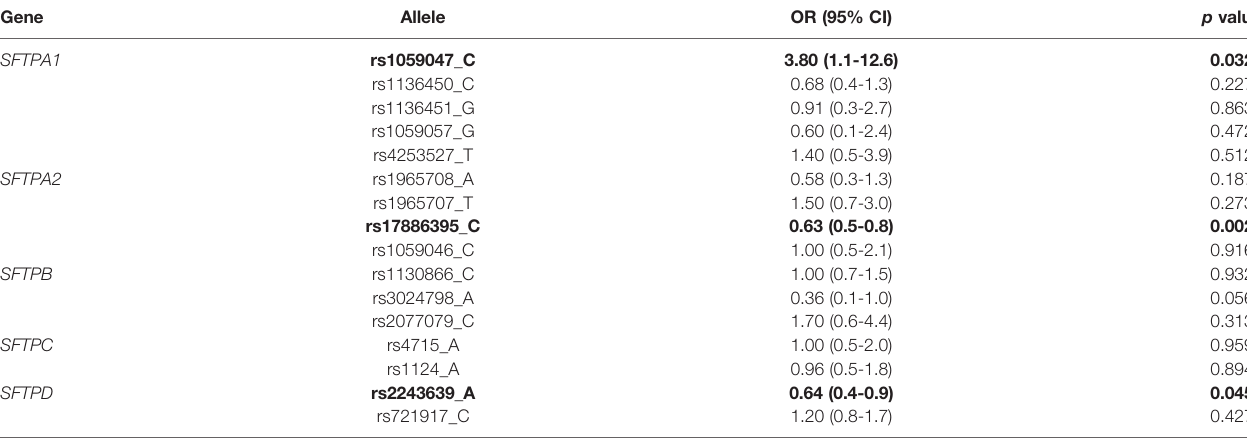
TABLE 2 | Severe RSV vs moderate RSV using the multivariate logistic analysis after adjusting for covariates (age, ethnicity, co-infection, smoke and pet exposure). Gene Allele